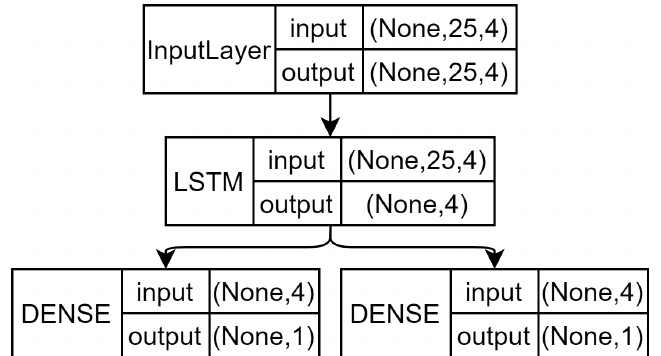
Figure A3. Meijner’s architecture block